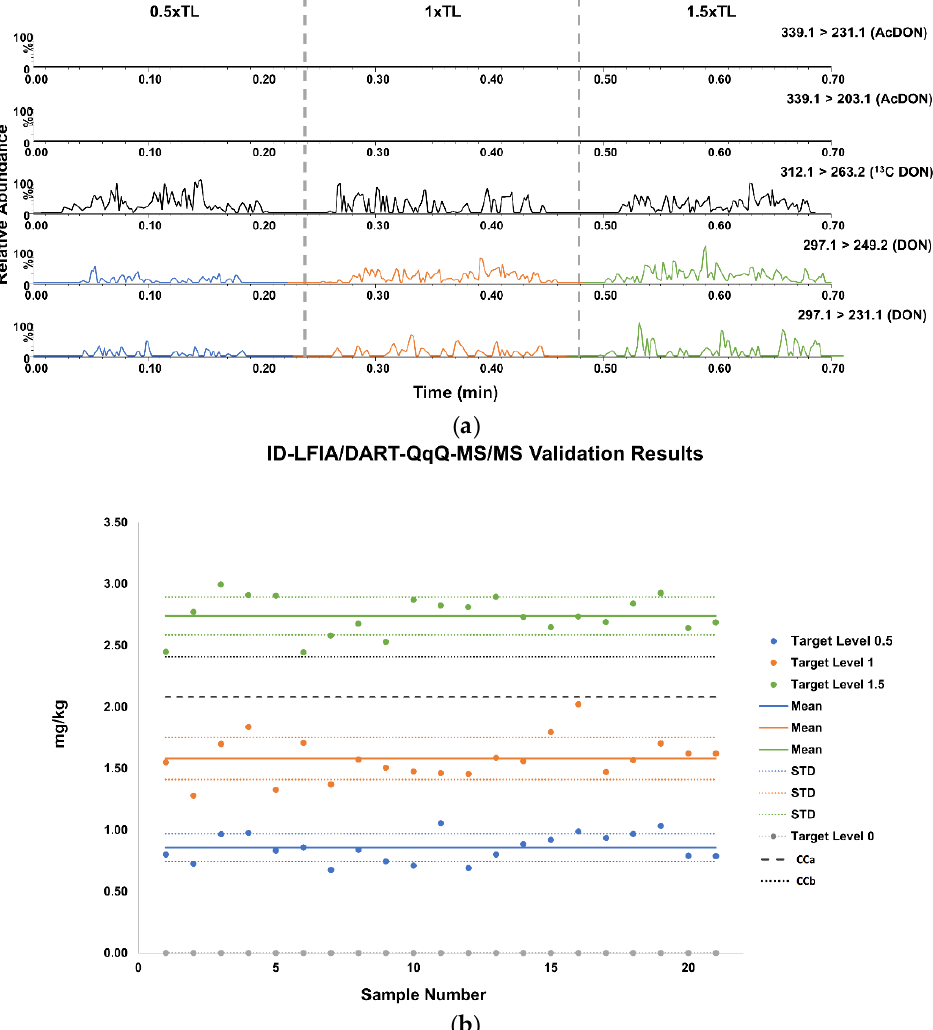
Figure 5. ( a ). Representative chronograms for DON-spiked wheat samples used to develop the ID-LFIA, retrieved in dissociation solution and analyzed by DART-QqQ-MS/MS, demonstrating the three distinct spiking levels in blue 0.5× TL, orange 1× TL, and green 1.5× TL. 13 C 15 DON is added as an internal standard before the MS/MS analysis. ( b ). Data analysis of 21 blank wheat samples, and spiked versions thereof in ID-LFIA/DART-QqQ-MS/MS, at three target level concentrations in blue 0.5× TL, orange 1× TL, and green 1.5× TL.